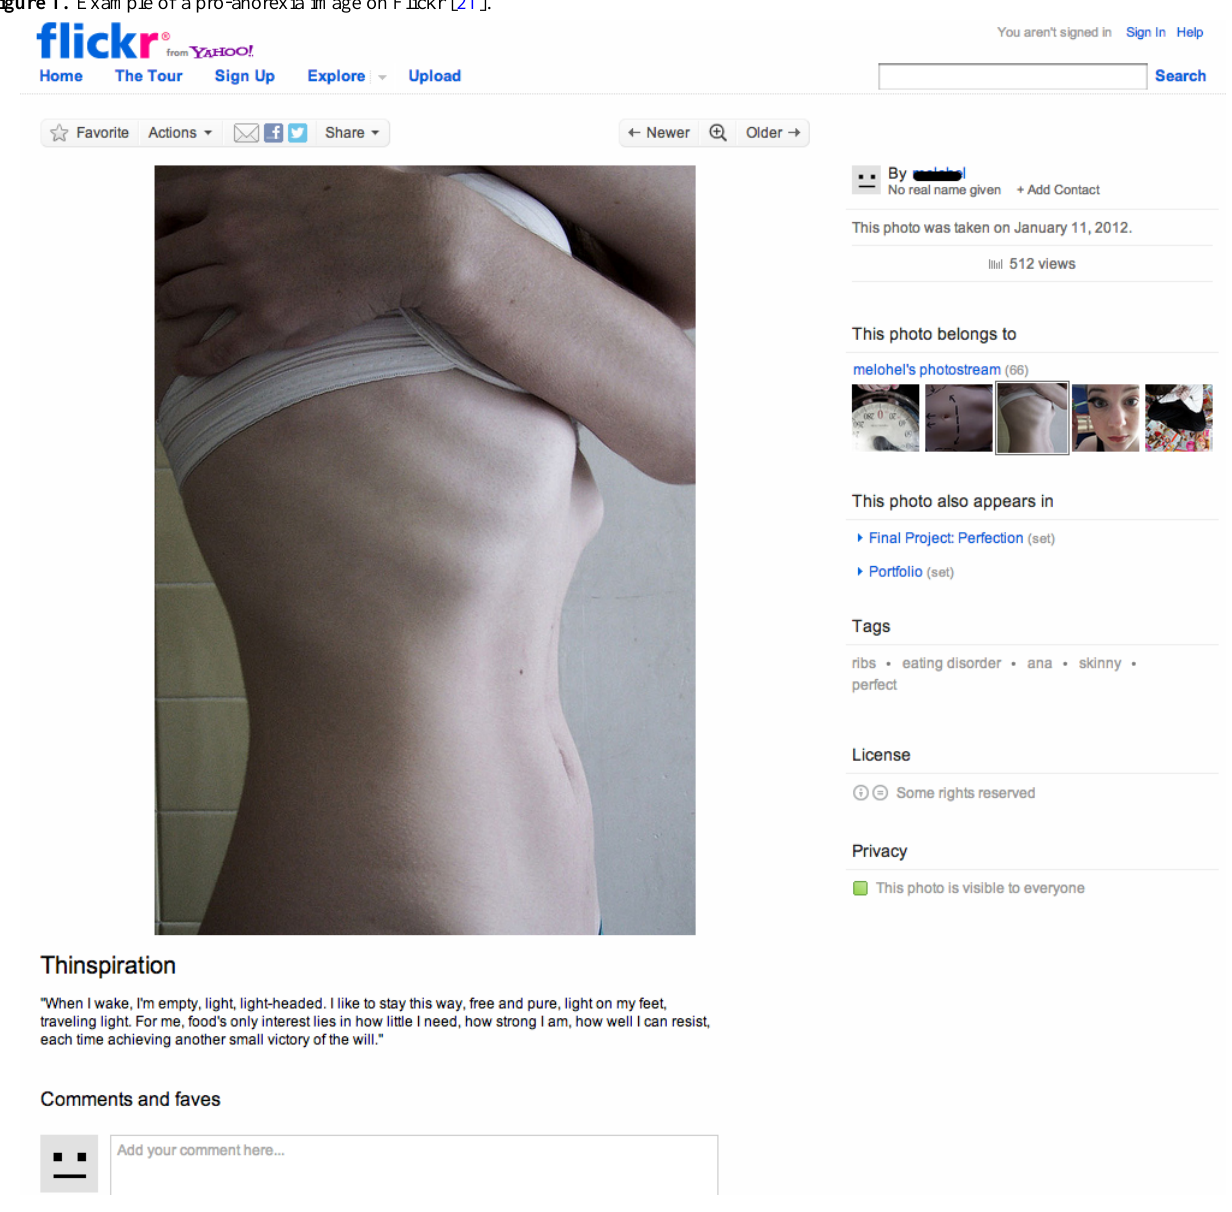
Figure 1. Example of a pro-anorexia image on Flickr